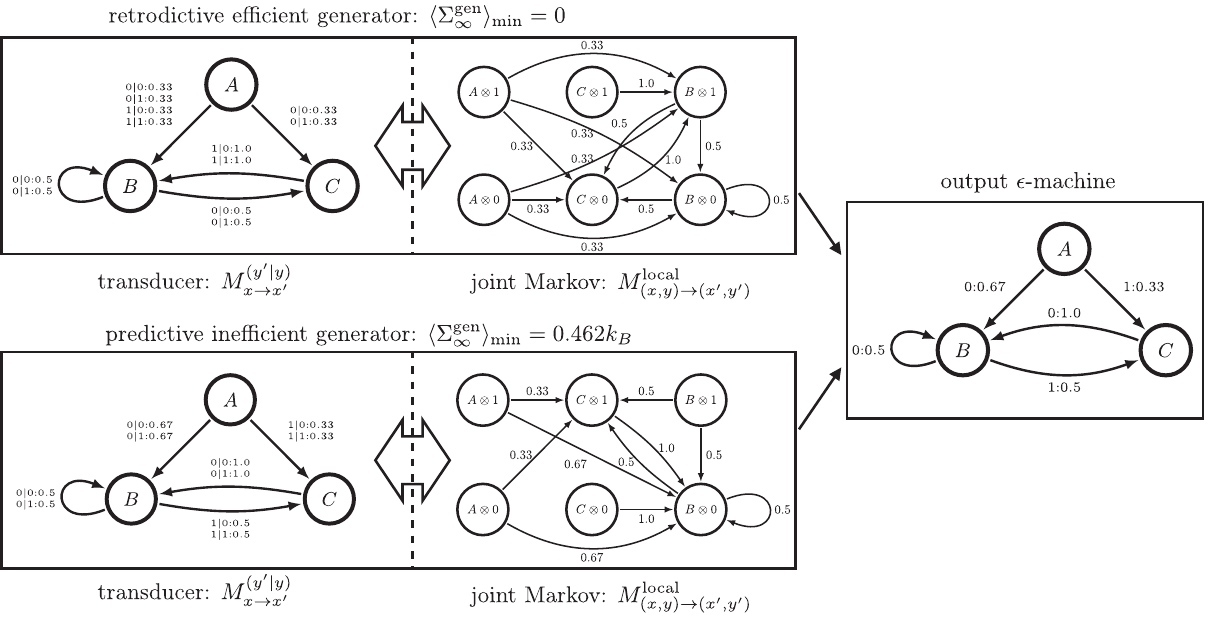
FIG. 6. Alternative generators of the golden mean process. Right: The process ’ s ϵ -machine. Top row: Optimal generator designed using the topology of the minimal retrodictive generator. It is efficient, since it stores as little information about the past as possible, while still storing enough to generate the output. Bottom row: The predictive generator stores far more information about the past than necessary, since it is based off the predictive ϵ -machine. As a result, it is far less efficient. It dissipates at least 2 symbol and requires that much more work energy per symbol